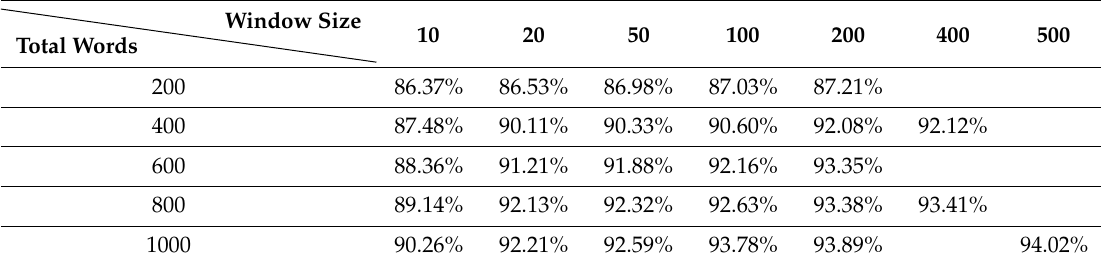
Table 2. Model CNN_Random_Agg experimental results.